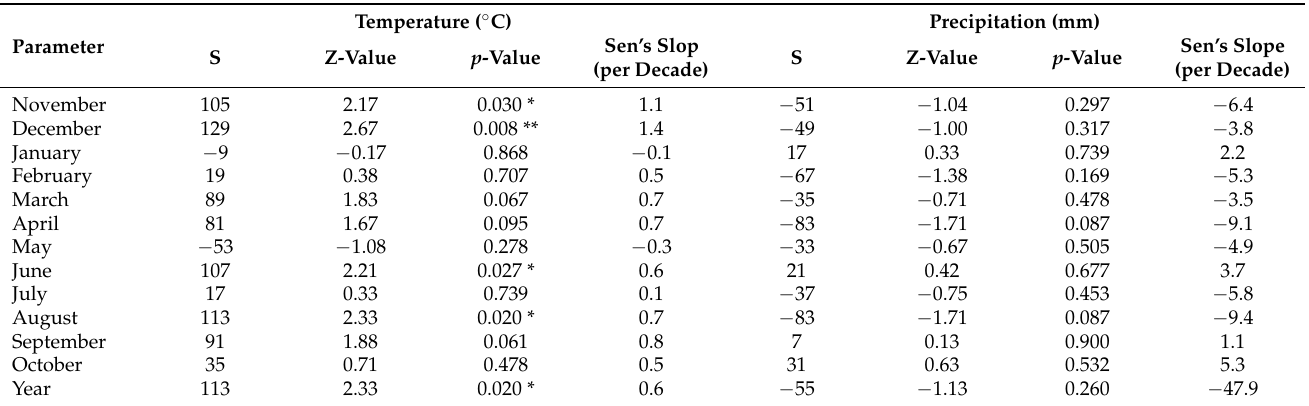
Table 3. Results of trend analyses for air temperatures and precipitation at the climatological sta- tion